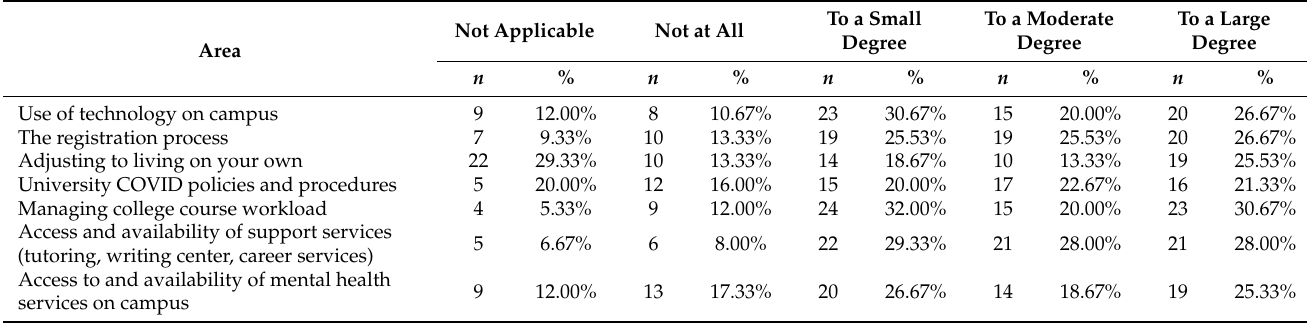
Table 3. Perceptions on Orientation Events/First Year